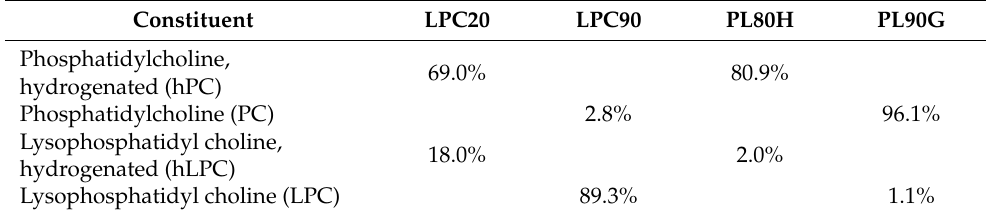
Table 1. Major constituents of the phospholipid